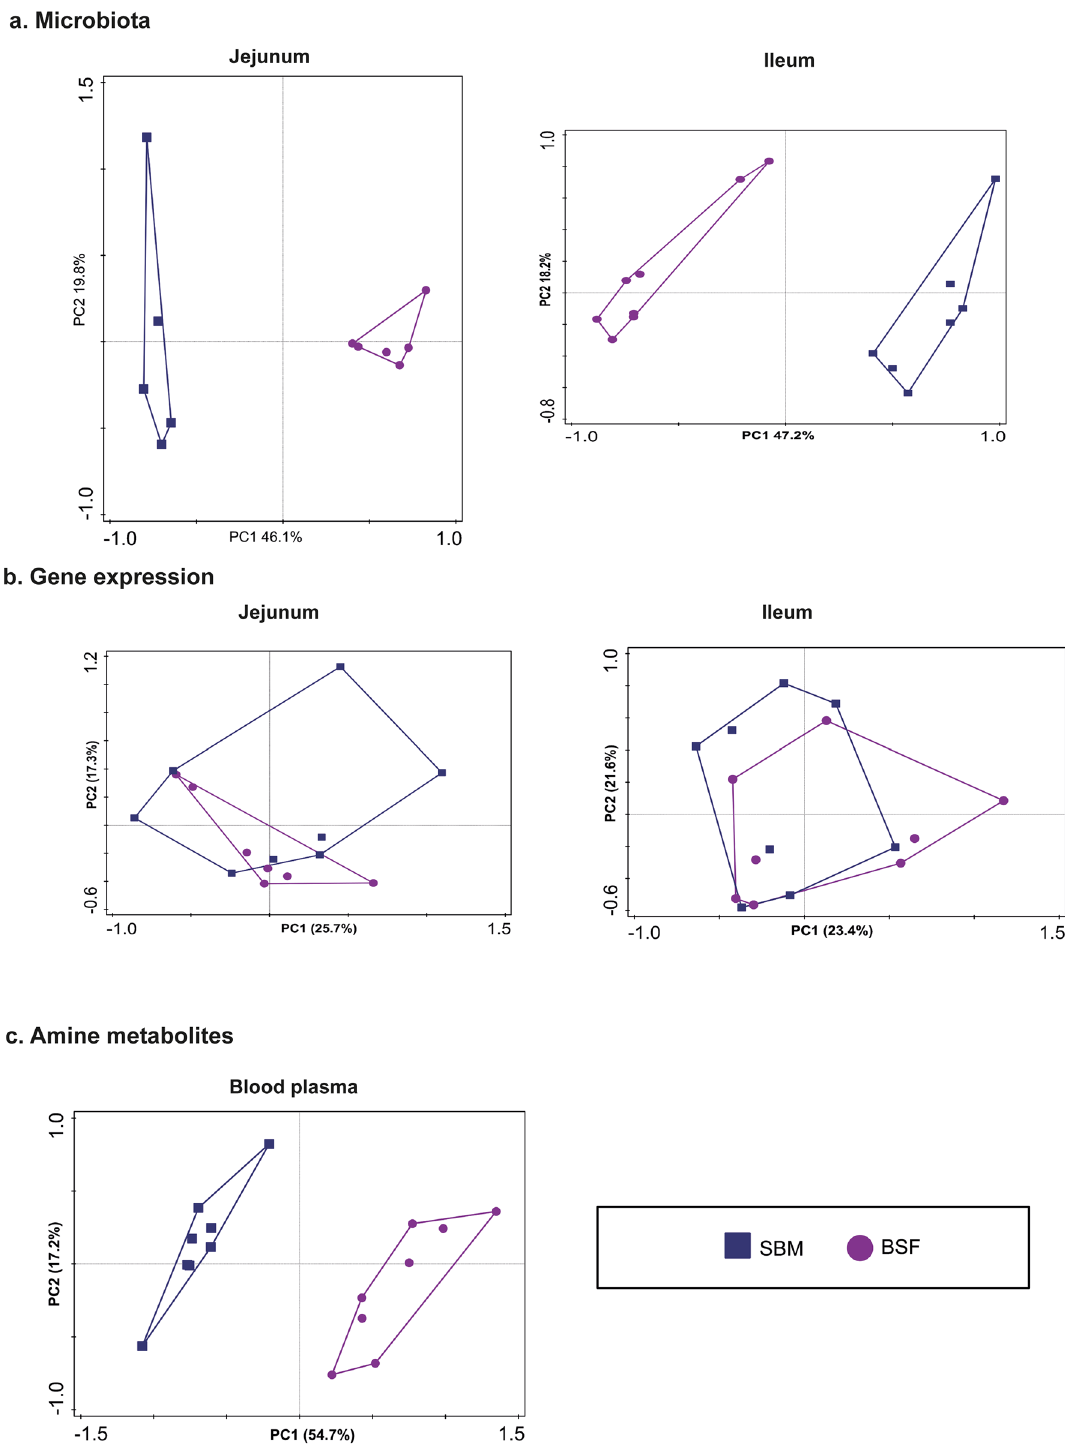
Figure 2. Response of pigs fed a diet with either soybean meal (SBM) or black soldier fly (BSF) as single protein source. Principal Component Analysis (PCA) plot explaining variation in the in ( a ) intestinal microbiota composition, ( b ) gene-expression in intestinal mucosal tissue, and ( c ) systemic amine metabolite profiles. The PCA displays 95% confidence regions for each dietary